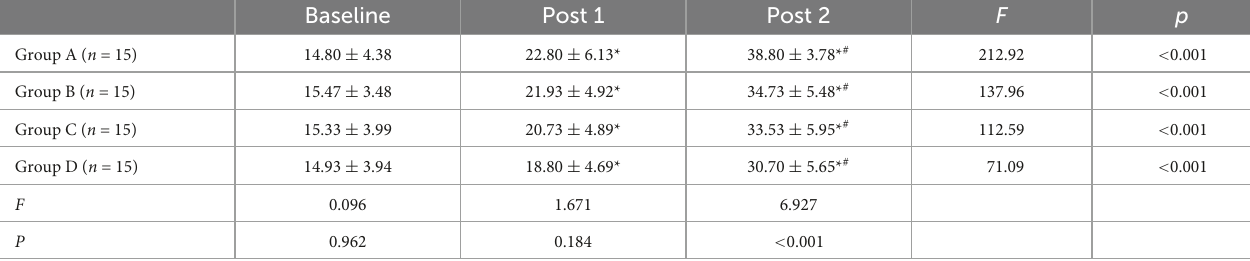
TABLE 2 Fugl-Meyer Assessment of the Upper Extremity (FMA-UE) score for all the groups at different time points ( x ± S). Baseline Post 1 Post